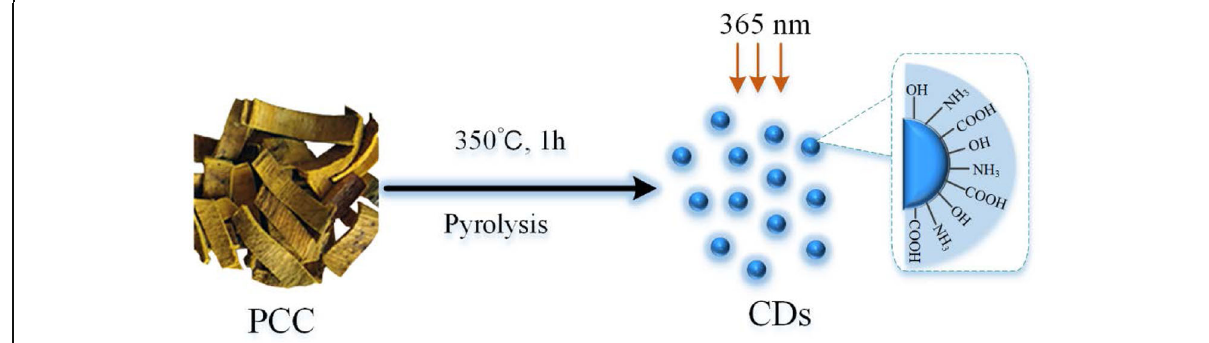
Fig. 1 Illustration of the formation process of carbon dots (CDs) from Phellodendri Chinensis Cortex (PCC) by pyrolysis